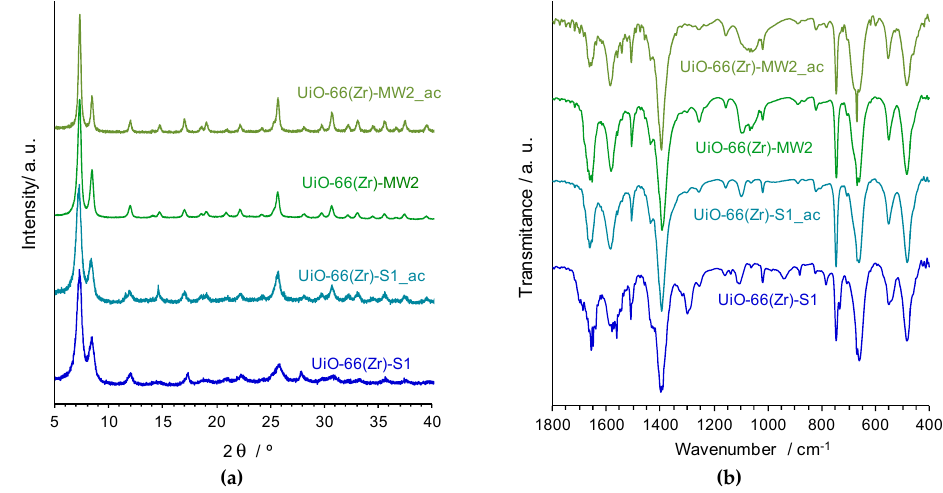
Figure 7. PXRD patterns ( a ) and FTIR-ATR spectra ( b ) of the UiO-66(Zr)-S1 and UiO-66(Zr)-MW2 materials in comparison with those after catalytic utilization [UiO-66(Zr)-S1_ac and UiO-66(Zr)-MW2_ac].